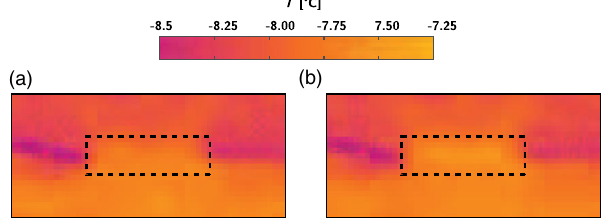
FIG. 7. Measurement of local heating during sliding. Measure- ments are obtained using an infrared camera Flir A600 series. The temperature scale is shown on right-hand axis. (a) At rest with V ¼ 0 . (b) Under sliding conditions with V ¼ 0 . 4 m s − 1 . Under sliding, we measure an average heating Δ T ≈ 0 . 1 °C over a zone of ≈ 300 μ m thickness (inside black dashed box).